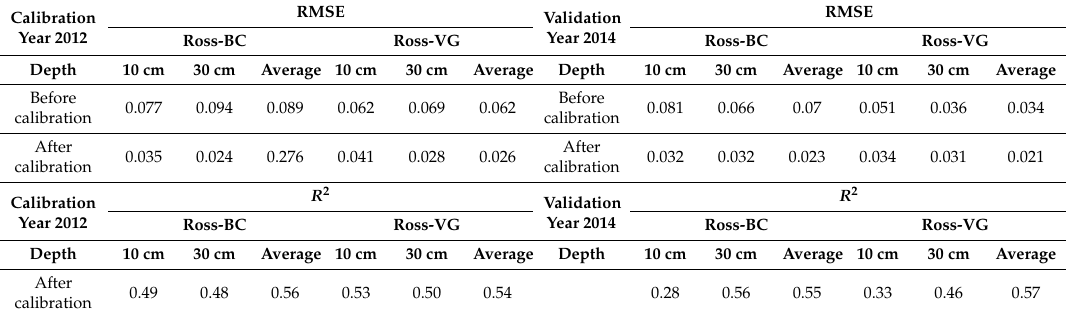
Table 7. Performances of the simulation of soil moisture based on Ross Model based on Brooks and Corey and Van Genuchten parametric equations before and after calibration for 2012 and 2014 cropping seasons.